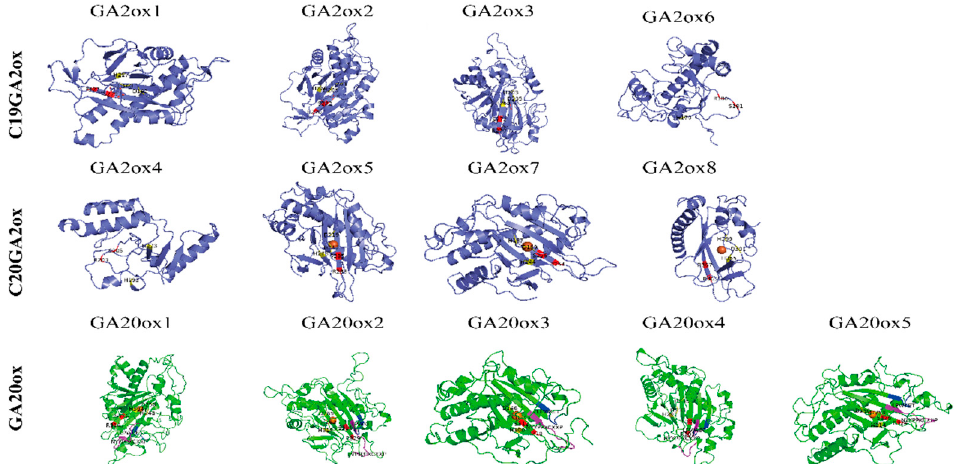
Figure 3. 3D structures of LcGA oxidases showing functional sites. The conserved motif related GA substrate binding site and 2-oxoglutarate-binding motif were display the purple and blue bands. The amino acid residues that bind the Fe2+ and interacted with the 5-carboxylate of 2-oxoglutarate are highlighted in yellow and red, respectively.